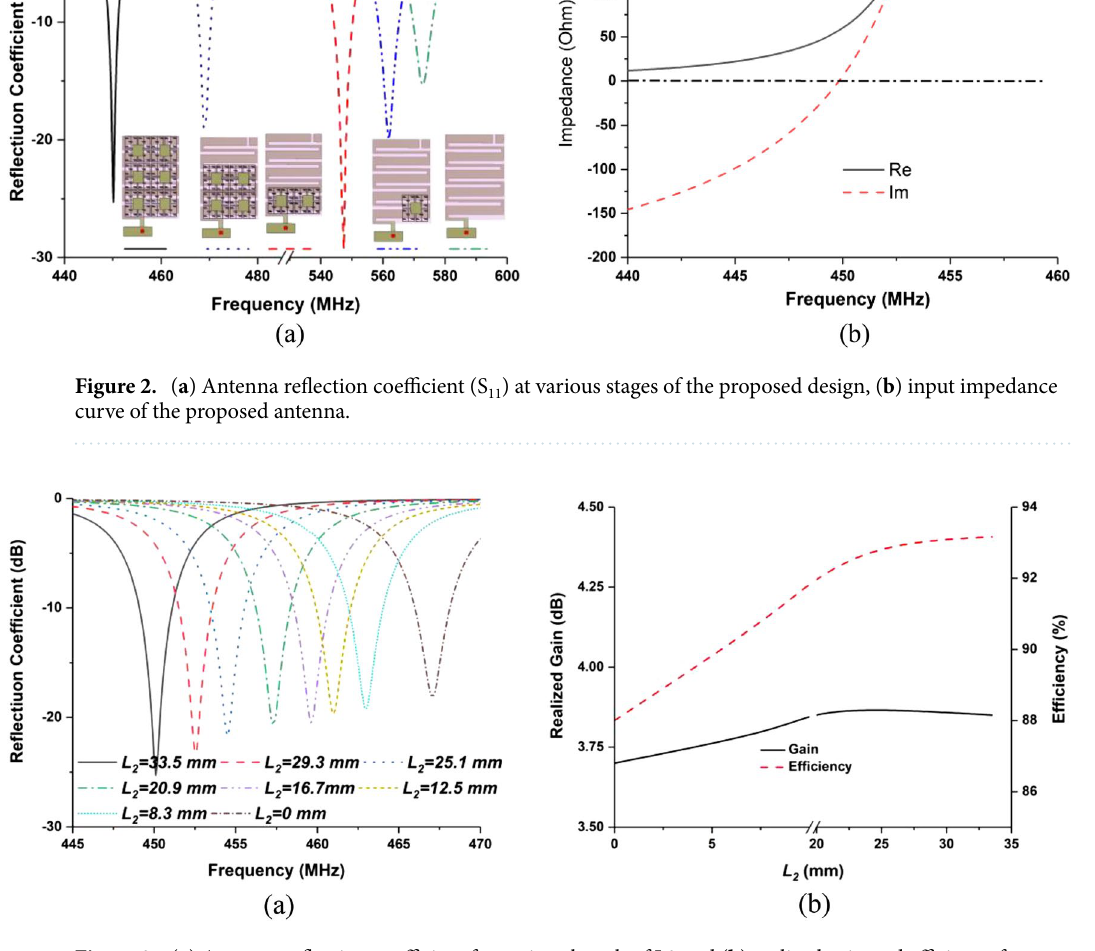
Figure 3. ( a ) Antenna reflection coefficient for various length of L2 and ( b ) realized gain and efficiency for different values of